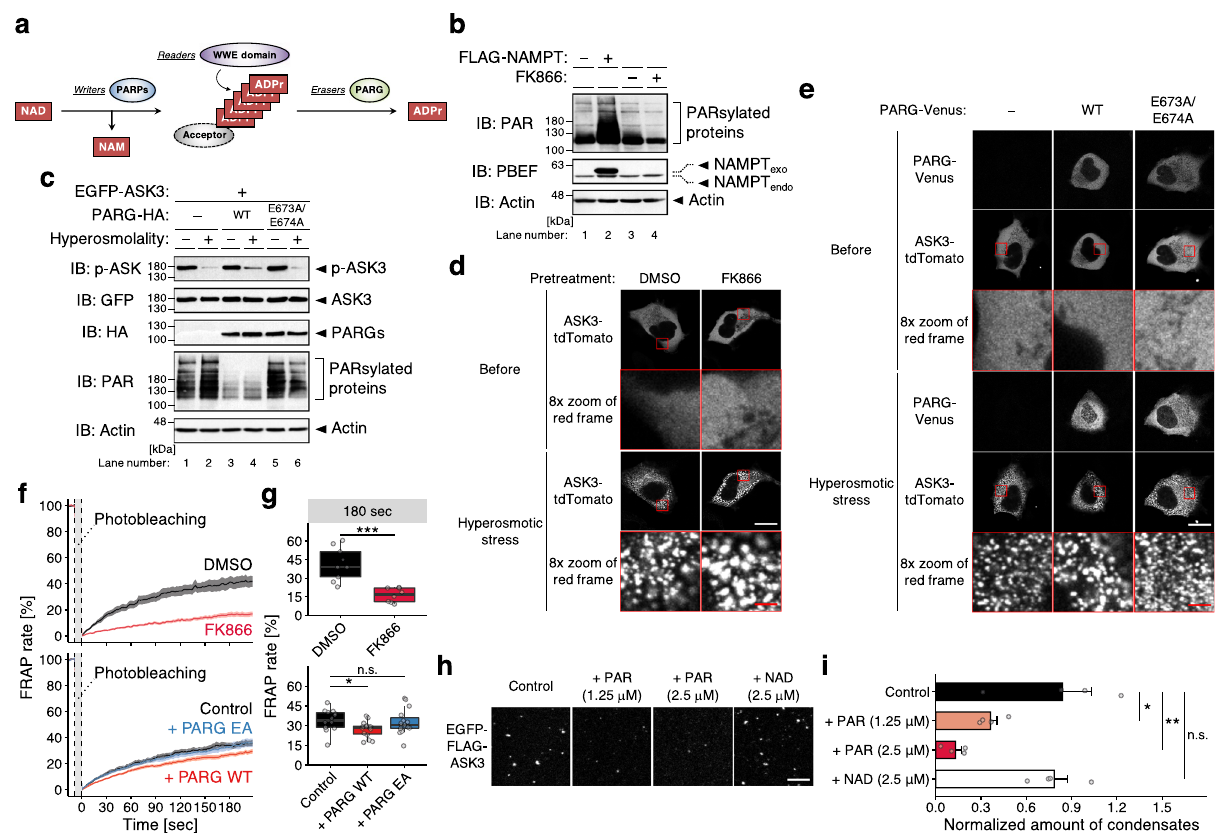
Fig. 5 Poly(ADP-ribose) keeps ASK3 condensates in the liquid phase for ASK3 inactivation. a Diagram of the poly(ADP-ribosyl)ation (PARsylation) dynamics. Rectangle: NAD-related molecule, arrow: reaction, ellipse: enzyme, ADPr: ADP-ribose. b Effects of NAMPT overexpression or inhibition on the amount of PAR in HEK293A cells. FK866 ( − ): dimethyl sulfoxide (DMSO), solvent for FK866; ( + ): 10 nM FK866; 18 – 24 h pretreatment. NAMPT exo : exogenously expressed NAMPT, NAMPT endo : endogenously expressed NAMPT. c Effects of PARG overexpression on ASK3 activity under hyperosmotic stress in HEK293A cells. WT: wild-type, E673A/E674A: glycohydrolase-inactive mutant 41 . Hyperosmolality ( − ): 300 mOsm; ( + ): 425 mOsm; 10 min. b , c IB: immunoblotting. A representative image set from three ( b ) or four ( c ) independent experiments is presented (quanti fi cation: Supplementary Fig. 5h, i). d , e Effects of PAR depletion on ASK3 condensates in ASK3-tdTomato-transfected HEK293A cells. Hyperosmotic stress: 600 mOsm, 10 min. White bar: 20 μ m, red bar: 2.5 μ m. A representative image set from four independent experiments is presented. f , g Effects of PAR depletion on the FRAP of ASK3 condensates in ASK3-tdTomato-transfected HEK293A cells. Prior to the assay, cells were exposed to hyperosmotic stress (600 mOsm, 30 min). Data ( f ): mean ± SEM; data ( g ): center line = median; box limits = [ Q 1 , Q 3 ]; whiskers = [max(minimum value, Q 1 − 1.5 × IQR), min(maximum value, Q 3 + 1.5 × IQR)], where Q 1 , Q 3 and IQR are the fi rst quartile, the third quartile and the interquartile range, respectively; n = 8 (FK866), 9 (DMSO), 14 (Control), 15 ( + PARG WT and EA) cells pooled from three (top panels) or fi ve (bottom panels) independent experiments. * P < 0.05, *** P < 0.001, n.s. (not signi fi cant) according to two-sided Welch ’ s t -tests (with the Bonferroni correction in the bottom panel). d – g DMSO: solvent for FK866; FK866: 10 nM FK866; 18 – 24 h pretreatment. Control: empty vector, PARG WT: wild-type PARG-Venus, PARG EA: E673A/E674A mutant PARG-Venus. h , i Effects of PAR on solid-like ASK3 condensation in vitro. Control: 150 mM NaCl, 20 mM Tris (pH 7.5), 1 mM DTT, 20% PEG, 15-min incubation on ice. White